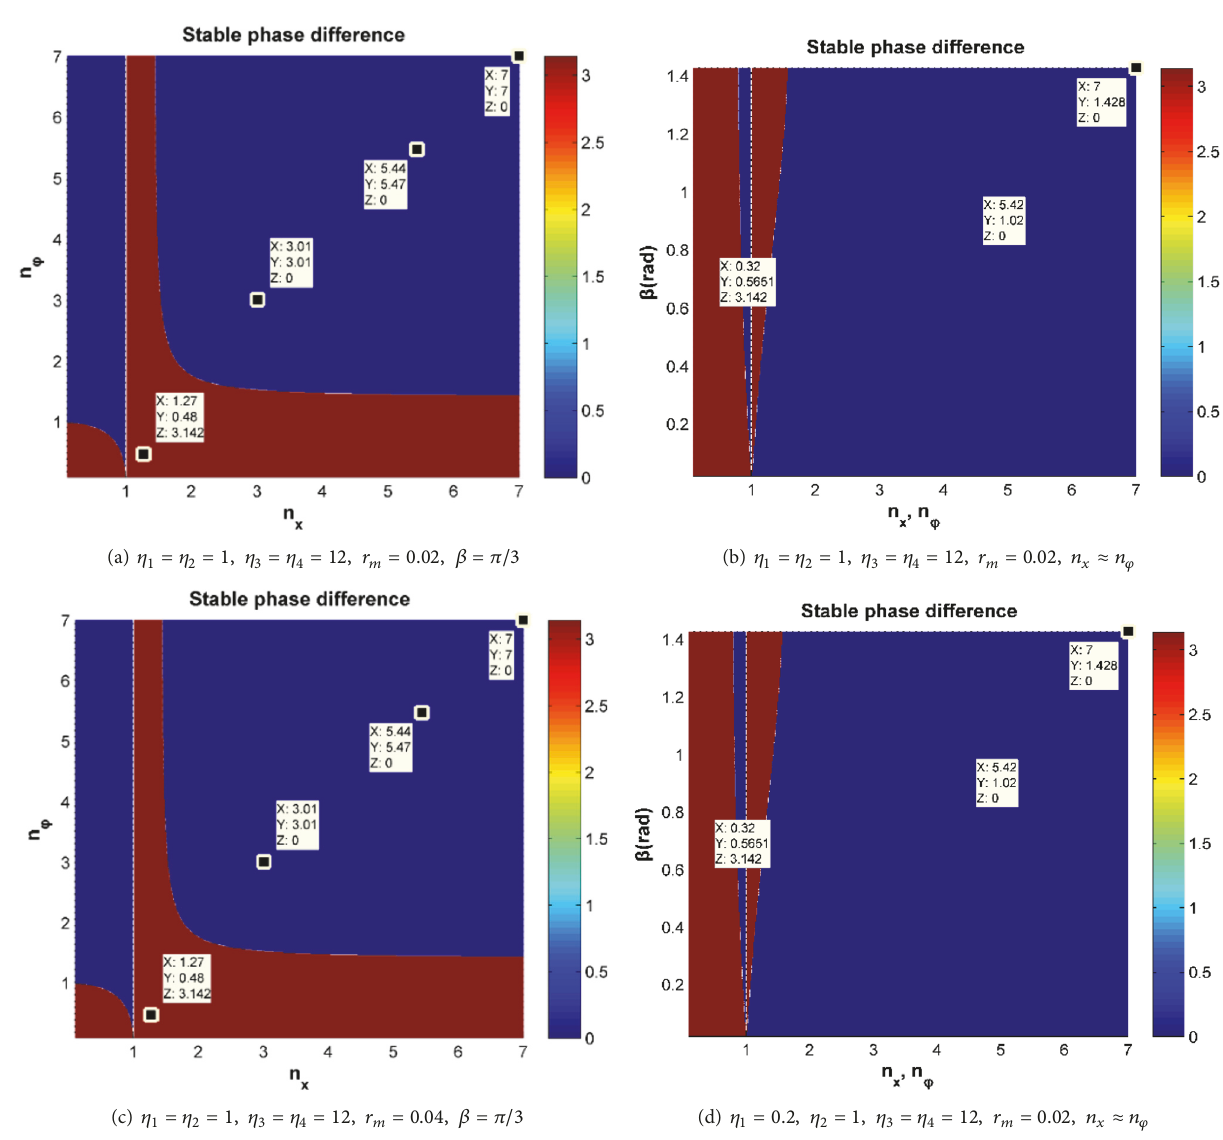
Figure 2: Stable phase difference when 𝜎 = −1